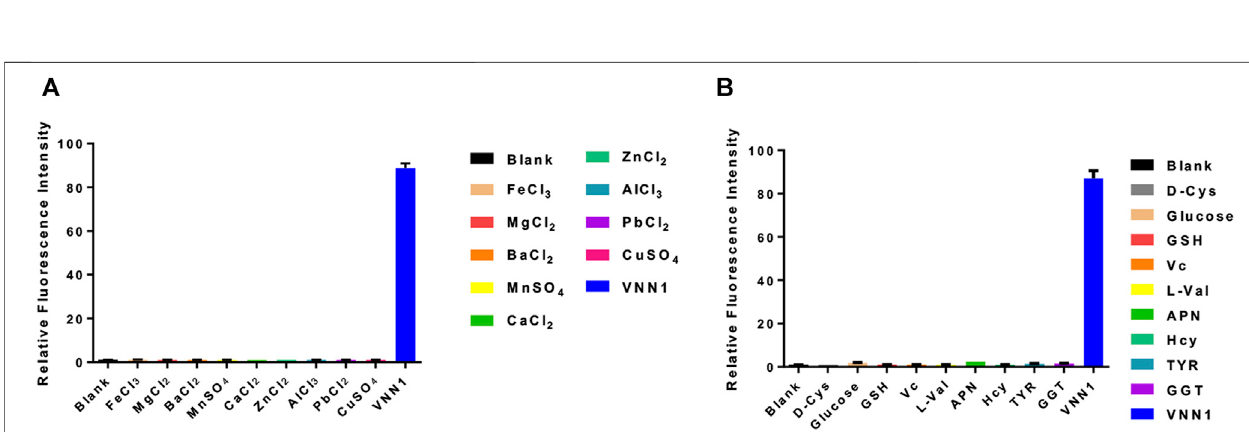
FIGURE 2 | Probe sensitivity test. (A) The relative fl uorescence intensity of the probe (20 μ M) and different concentrations of human recombinant VNN1 enzyme after incubation at 37 ° C for 30 min; (B) The linear relationship between the relative fl uorescence intensity and the concentration of pantothenate conforms to the linear equation y (cid:1) 0.9775 x + 11.17, which R 2 (cid:1) 0.9975.